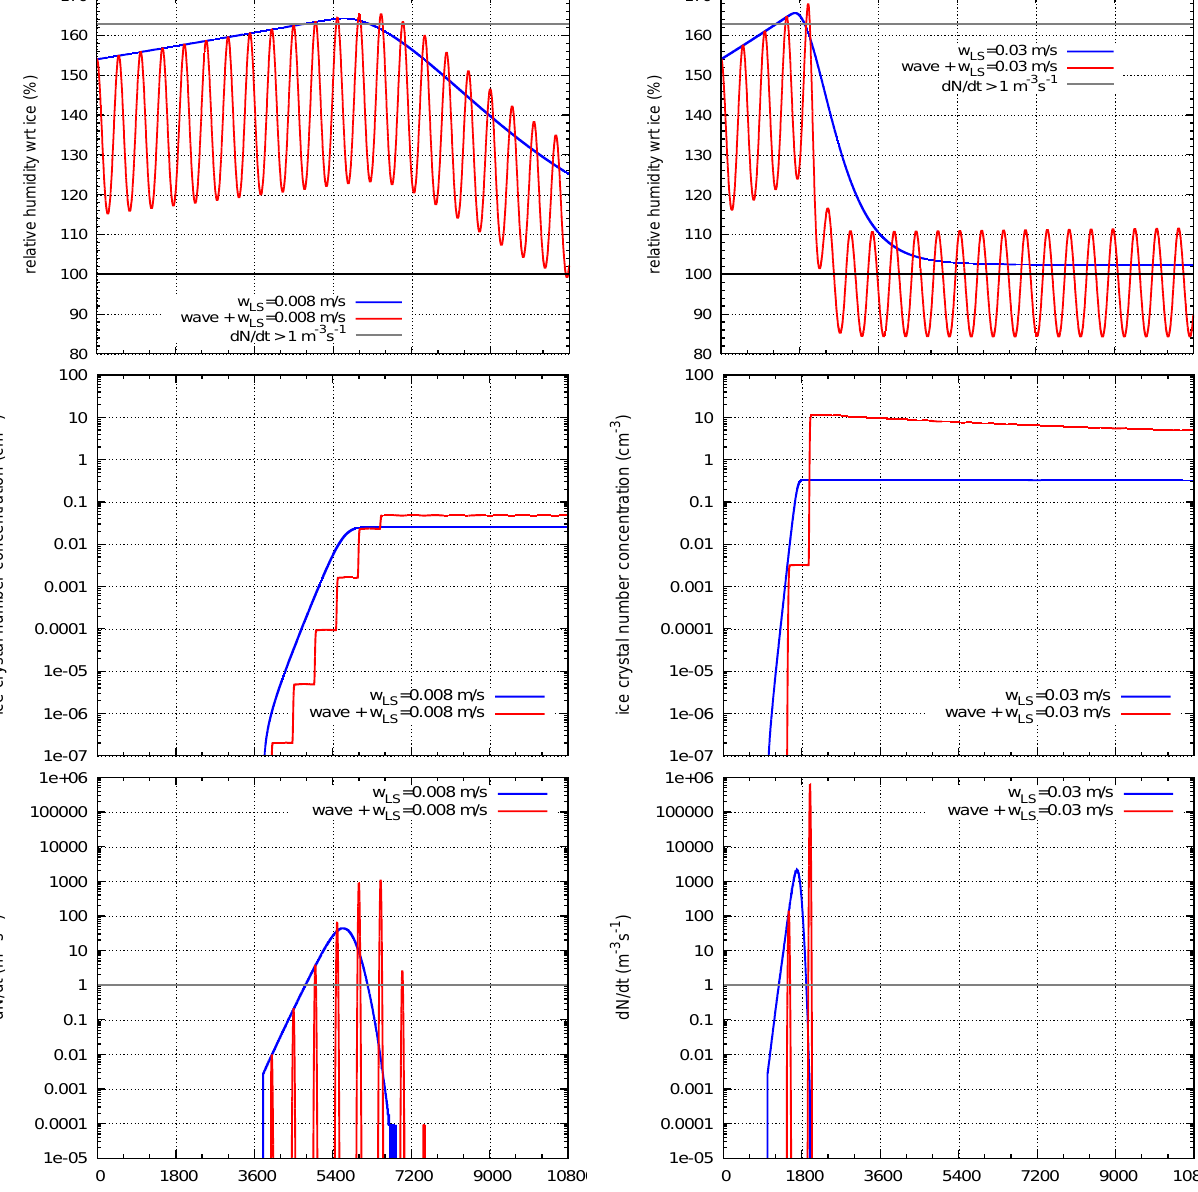
Fig. 4. Examples of cases of updraught scenarios. Left column: large-scale updraught w LS = 0 . 008ms − 1 (slow regime), right column: large-scale updraught w LS = 0 . 03ms − 1 (fast regime). Blue lines indicate constant updraught, red lines denote superposition of large-scale updraught and a short wave. Upper panel: time evolution of the relative humidity with respect to (wrt) ice (in %); saturation is indicated by a black line, the grey line indicates relative humidity values where the ice crystal concentration rate d N/ d t exceeds the value 1m − 3 s − 1 . Middle panel: time evolution of ice crystal number concentration. Lower panel: time evolution of ice crystal production rate d N/ d t ; the value 1m − 3 s − 1 is indicated by a grey line. Here, the stepwise character of the nucleation for the superimposed short wave (red line) can be seen in contrast to the continuous nucleation during a constant large-scale updraught (blue